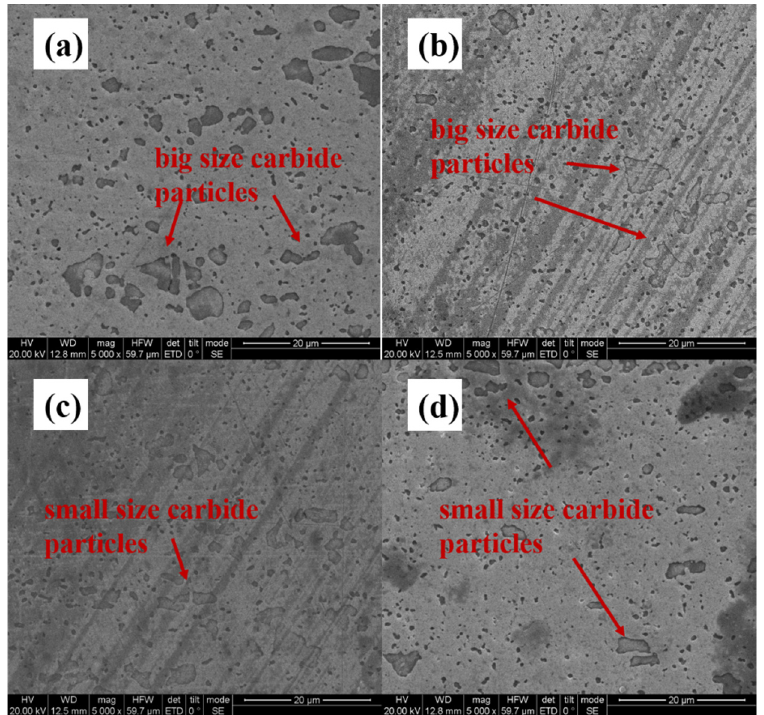
Figure 5. SEM images of samples after different numbers of laser shocks—( a ) LQ-LSP1; ( b ) LQ-LSP2; ( c ) LQ-LSP3; ( d ) LQ-LSP4.